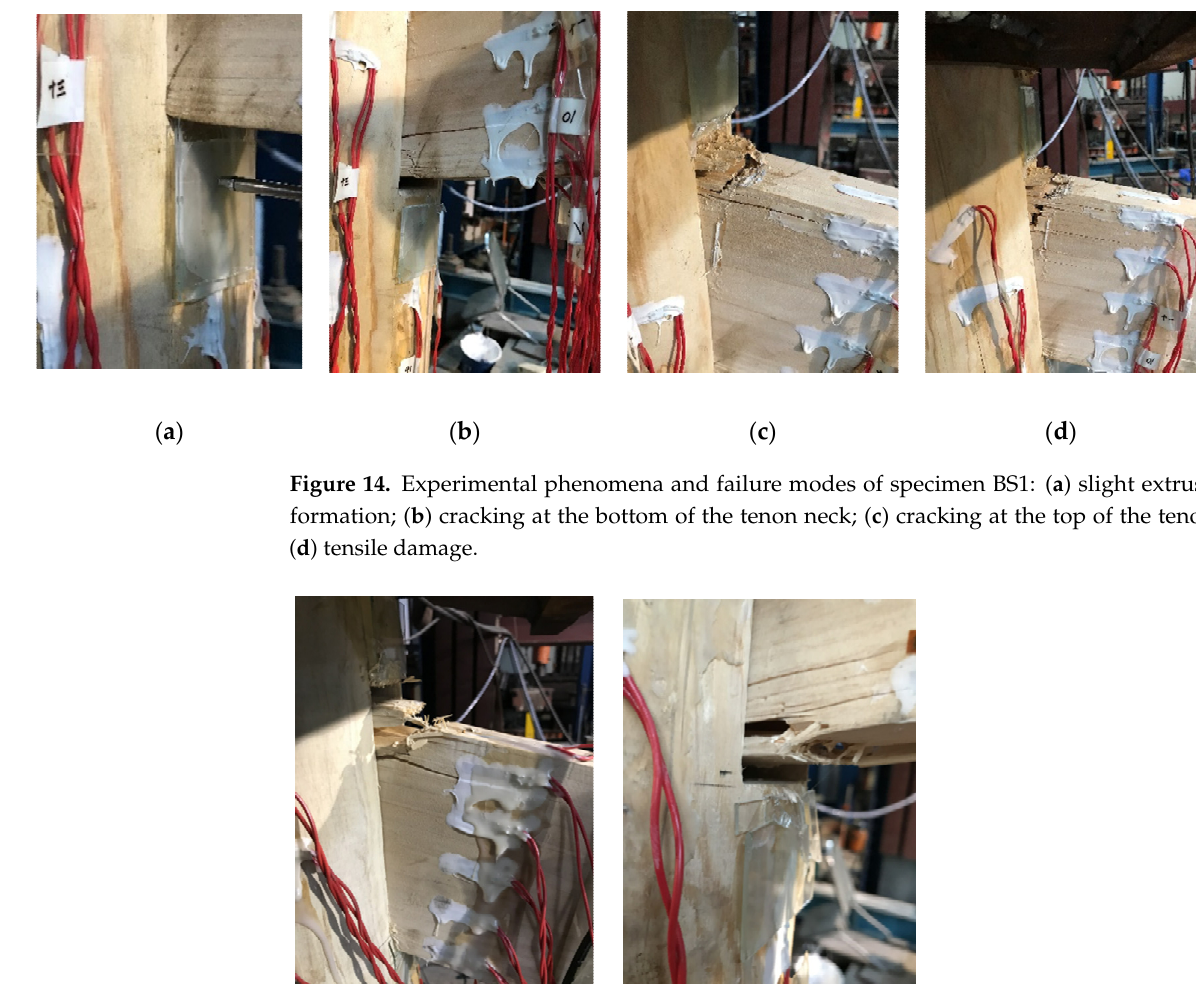
17 of 24 Figure 13. Loading diagram of the friction coefficient test. Note: the longitudinal grain direction of the parent specimen is horizontal; the longitudinal grain direction of the sub-specimen is vertical. 1